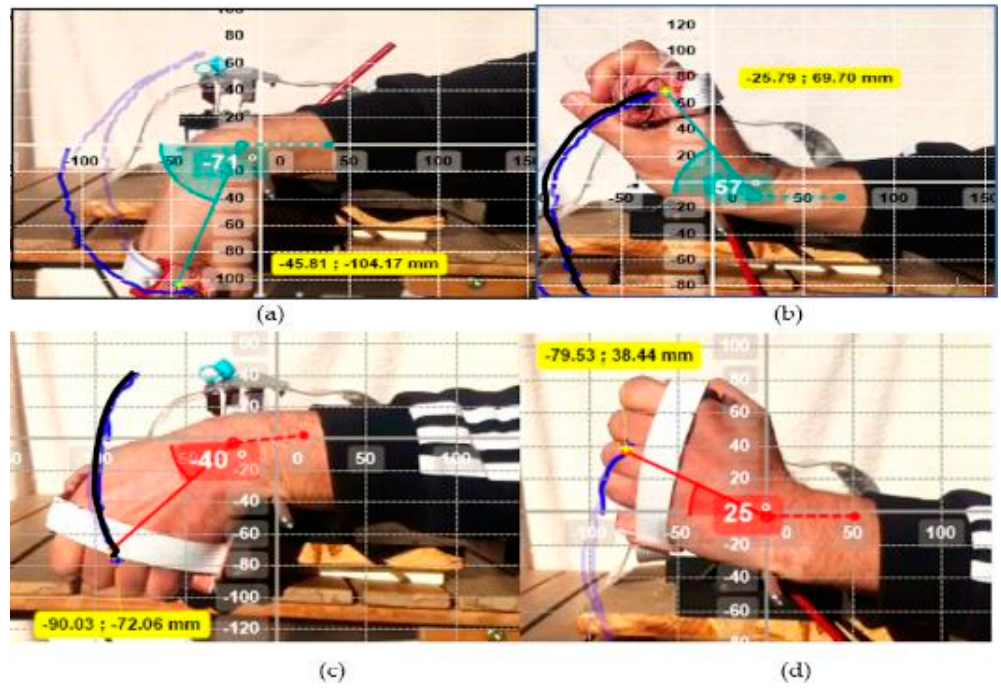
Figure 13. The real-time experiments of wrist joints workspace trajectories. ( a ), the actual ROM angle of the wrist fixing, the workspace trajectory, and the position caused by FWRMS. ( b ), actual wrist extension (blue curve) and desired (black curve) workspace trajectory and position. ( c ), the actual radial deviation of the wrist (blue curve) and the desired (black curve) workspace trajectory. ( d ), the actual wrist ulnar deviation ROM angle, workspace trajectory, and position caused by FWRMS.